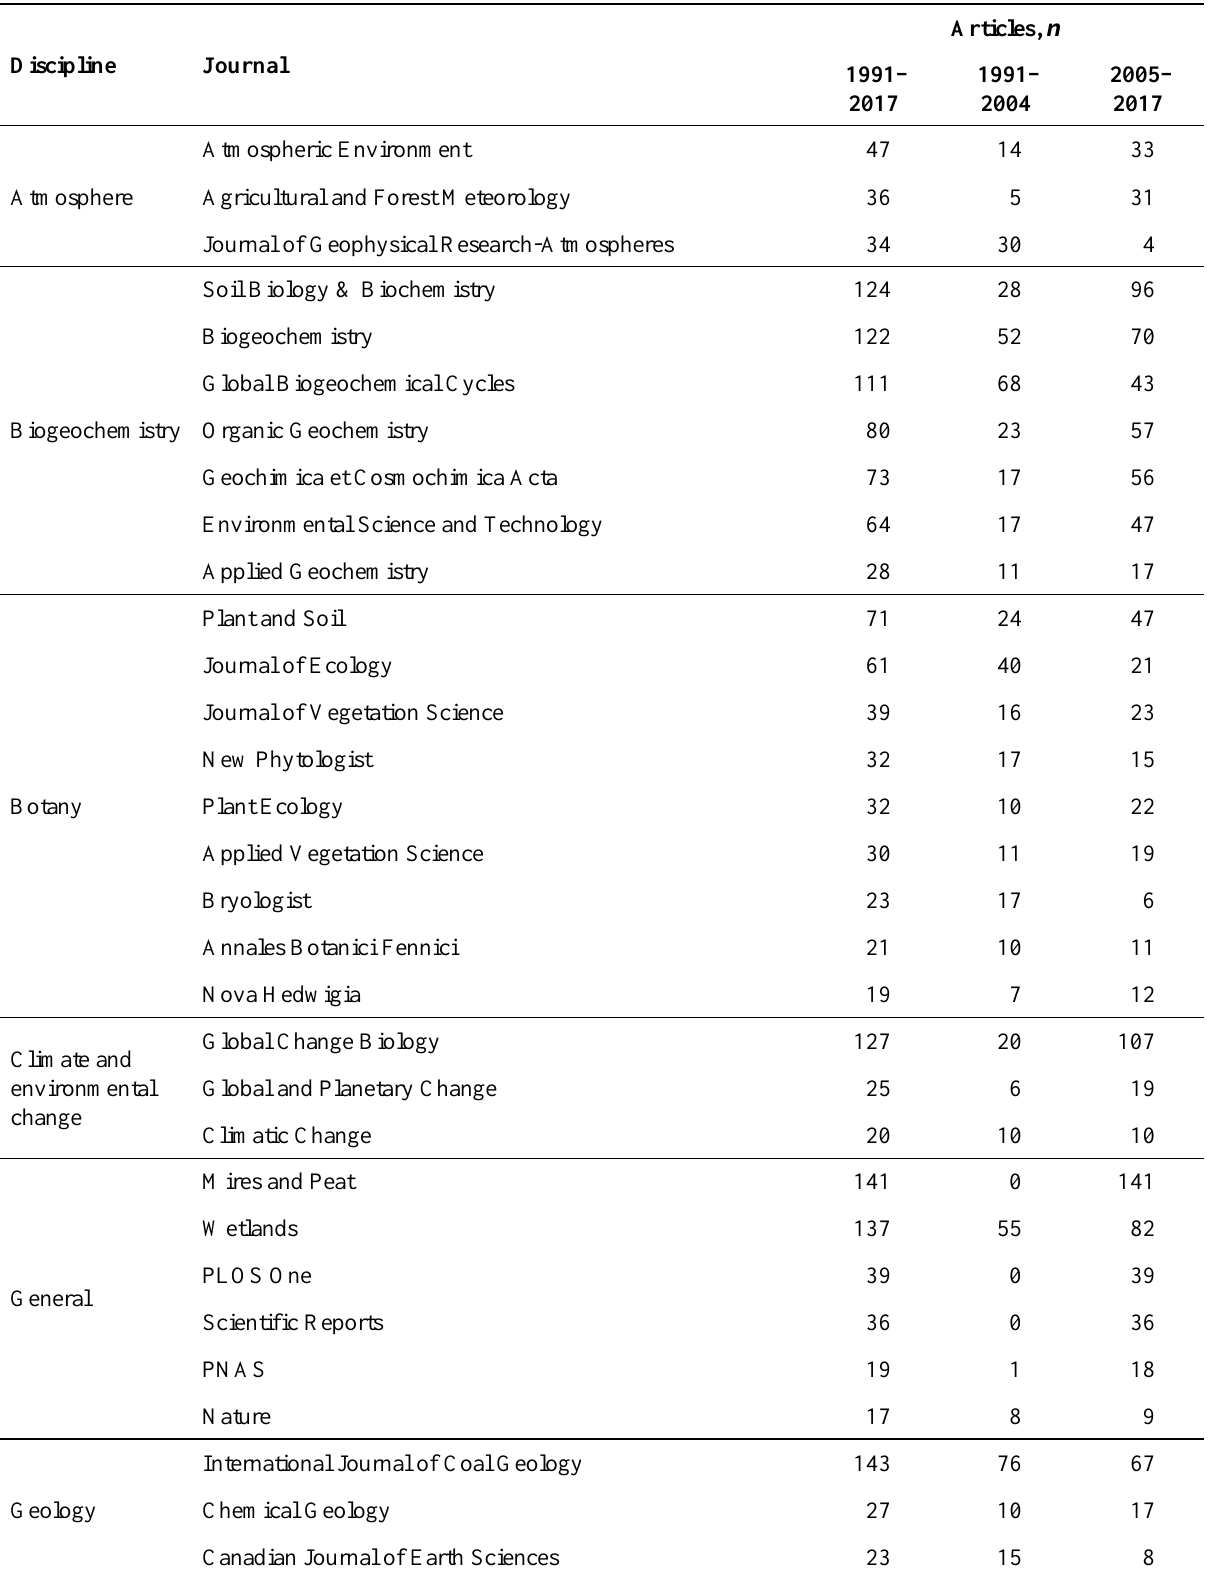
Table A1. Classification of the top 100 journals and number of articles published in peatland research. Within each discipline, journals are ranked according to the number of articles published between 1991 and